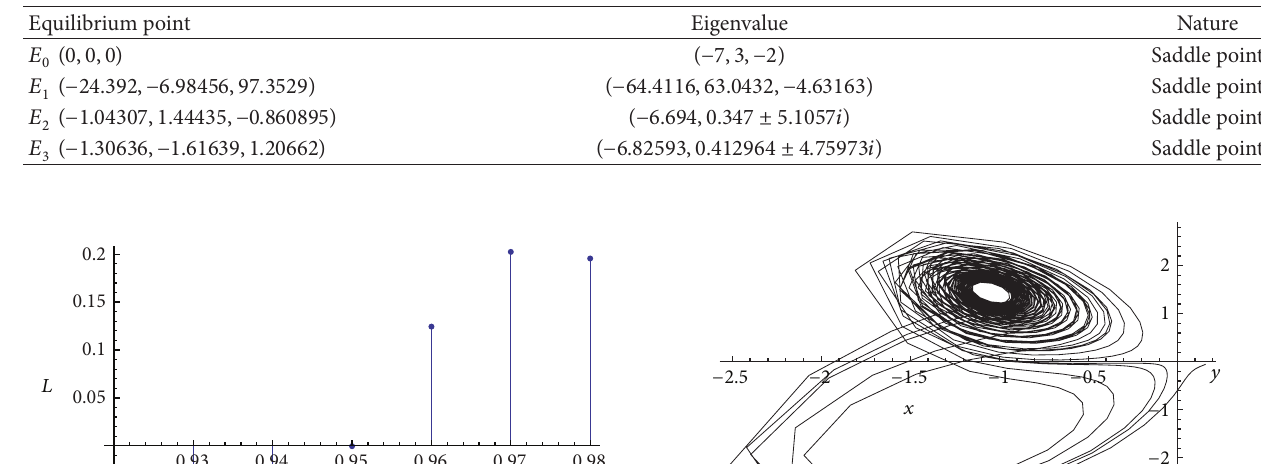
Table 1: Equilibrium points and corresponding eigenvalues.